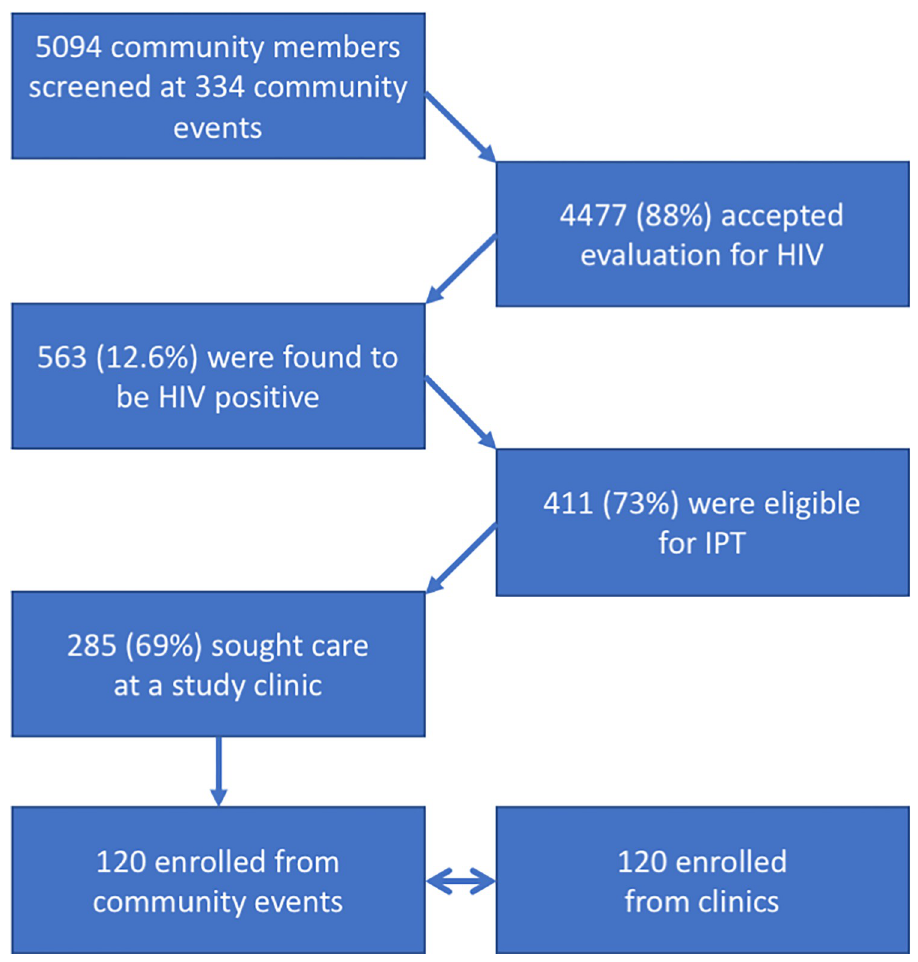
Fig 1. Flow chart depicting community-based TB/HIV screening to